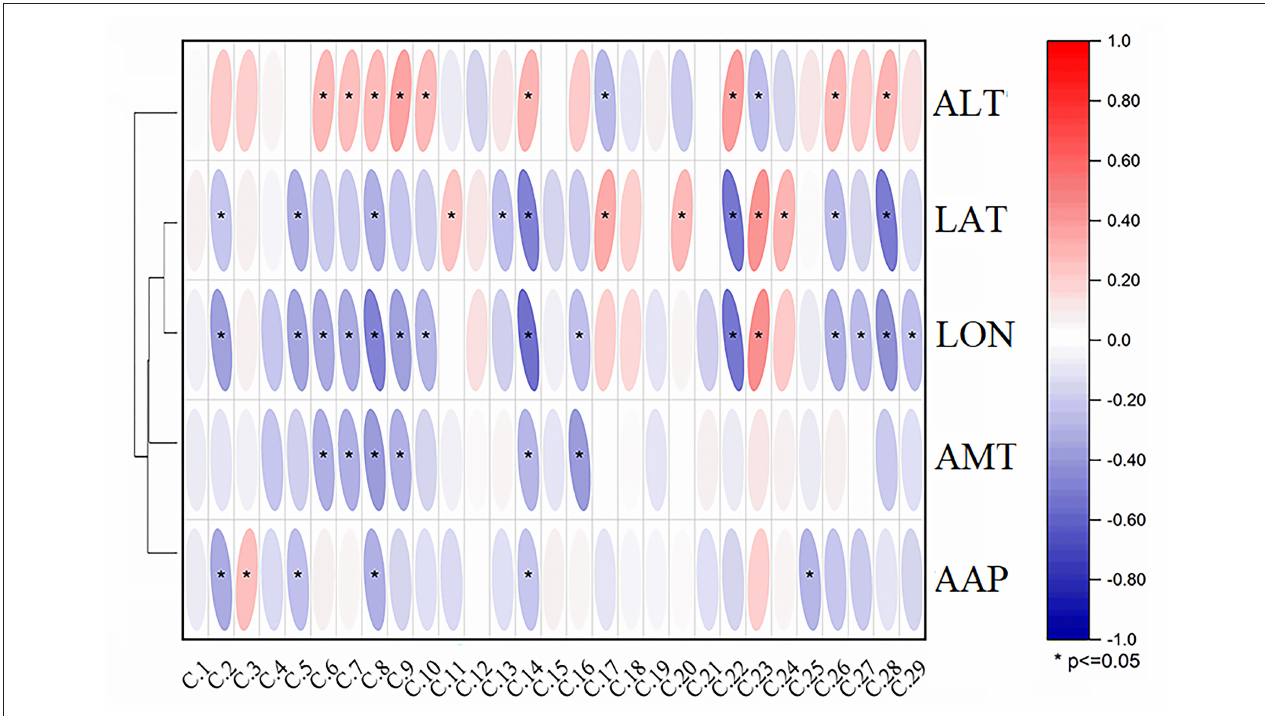
FIGURE 5 | Correlation analysis results of metabolites in A. tanguticus and environmental factors [altitude (ALT), longitude (LON), latitude (LAT), annual mean temperature (AMT) and annual average precipitation (AAP)].